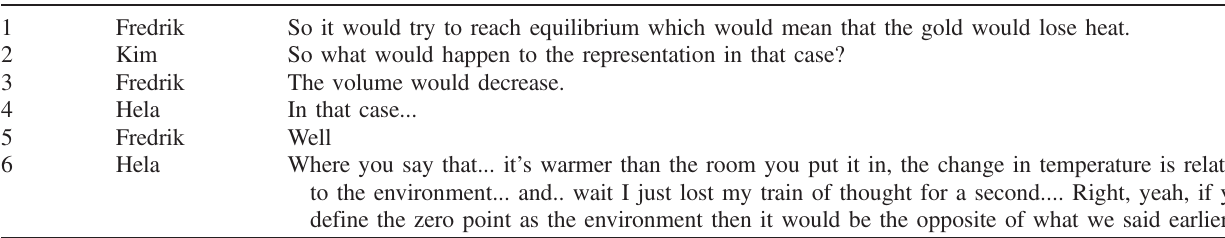
TABLE IV. Example of disciplinary